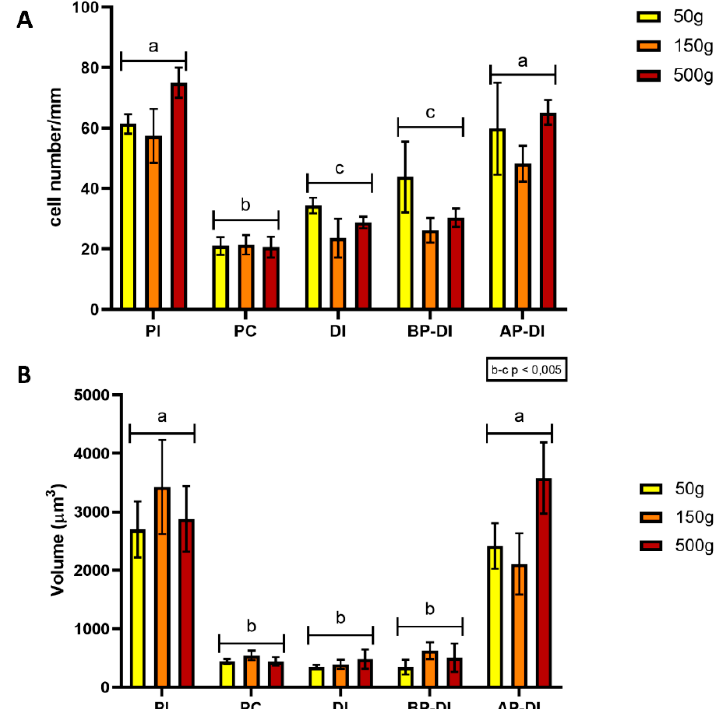
Figure 6. Goblet cells number ( A ) and volume ( B ) within five regions of the intestinal tract: proximal intestine (PI), pyloric caeca (PC), distal intestine (DI), basal (BP-DI) and apical part (AP-DI) of the complex folds of the distal intestine. Values are measured at three different stages of development (50, 150 and 500 g). a–c Different superscripts within the same histogram indicate significant differences ( p < 0.05 or p < 0.005) measured by two-way ANOVA (animal weight and intestinal tract: independent variables).